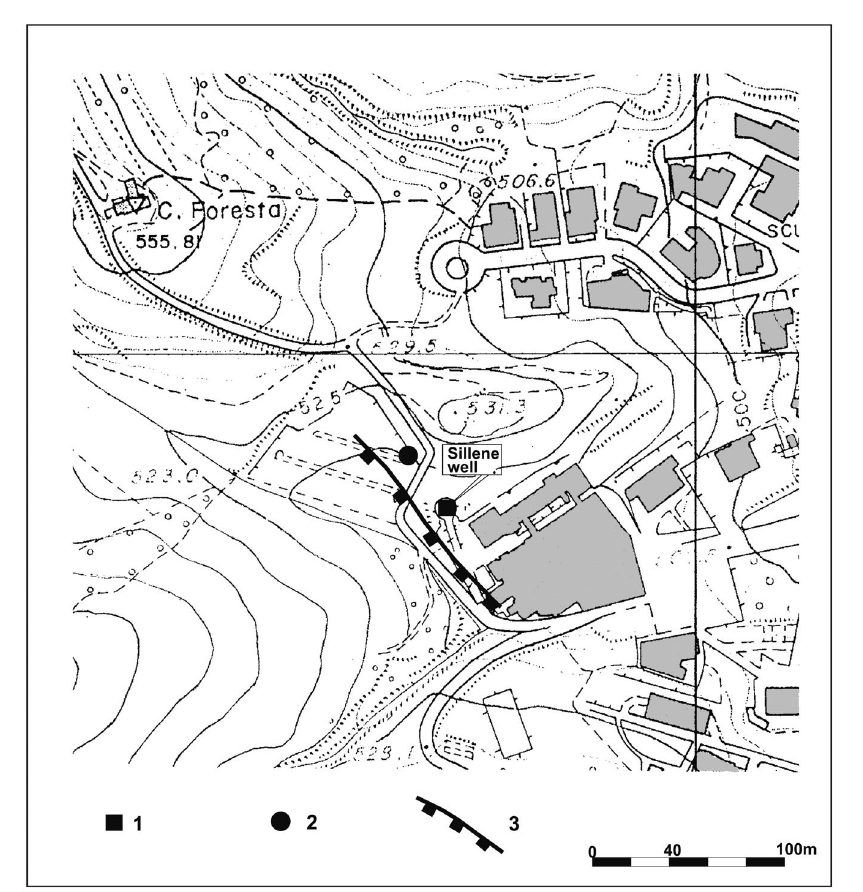
Fig. 10. Structural results from geophysical prospections. 1 = Sillene well; 2 = suggested location of the new well, and 3 = fault (rectangles show the lowered